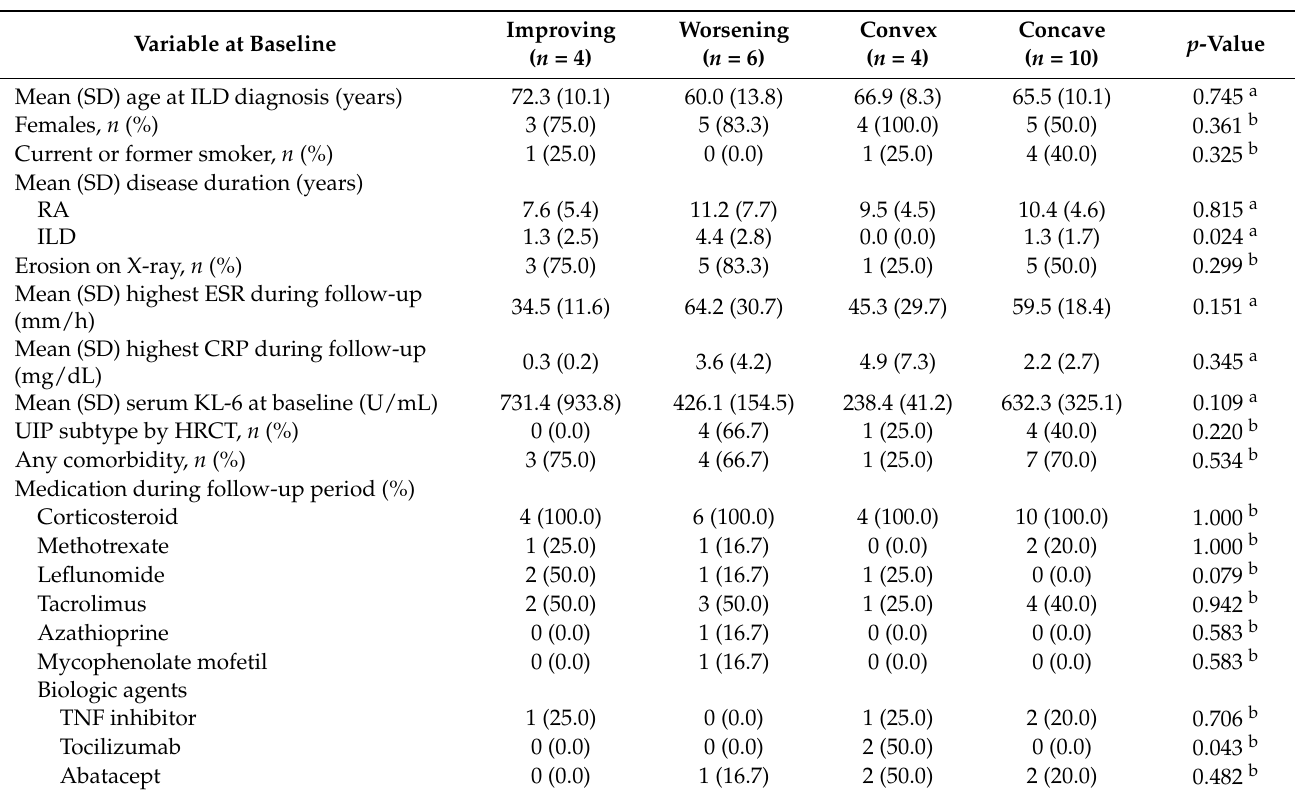
Table 2. Clinical characteristics of the patients with rheumatoid arthritis-associated interstitial lung disease upon changing pattern of QILD score (cohort 2, n =